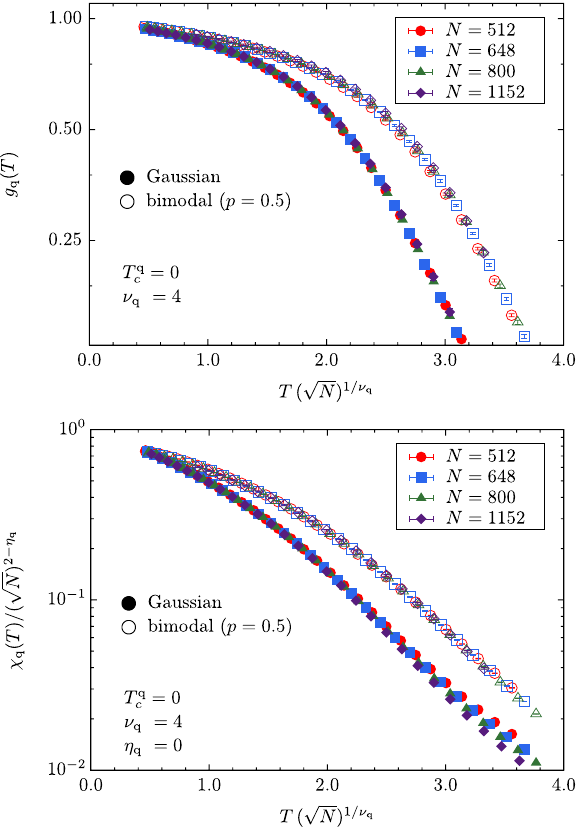
FIG. 2. Top panel: Finite-size scaling of the Binder parameter ffiffiffiffi p g N as a function of T ð Þ 1 = ν q for both Gaussian (full symbols) q and bimodal (open symbols) disorder on the Chimera topology. 4 in both cases. The data scale very well for T q c ¼ 0 and ν q ¼ Bottom panel: Finite-size scaling of the spin-glass susceptibility χ for both Gaussian and bimodal disorder. Plotted are ffiffiffiffi ffiffiffiffi p p q χ = ð N N Þ 2 − η q vs T ð Þ 1 = ν q . The data scale very well for q 4 , and η 0 . Note that there is no universality T q c ¼ 0 , ν q ¼ q ¼ violation. Error bars are smaller than the